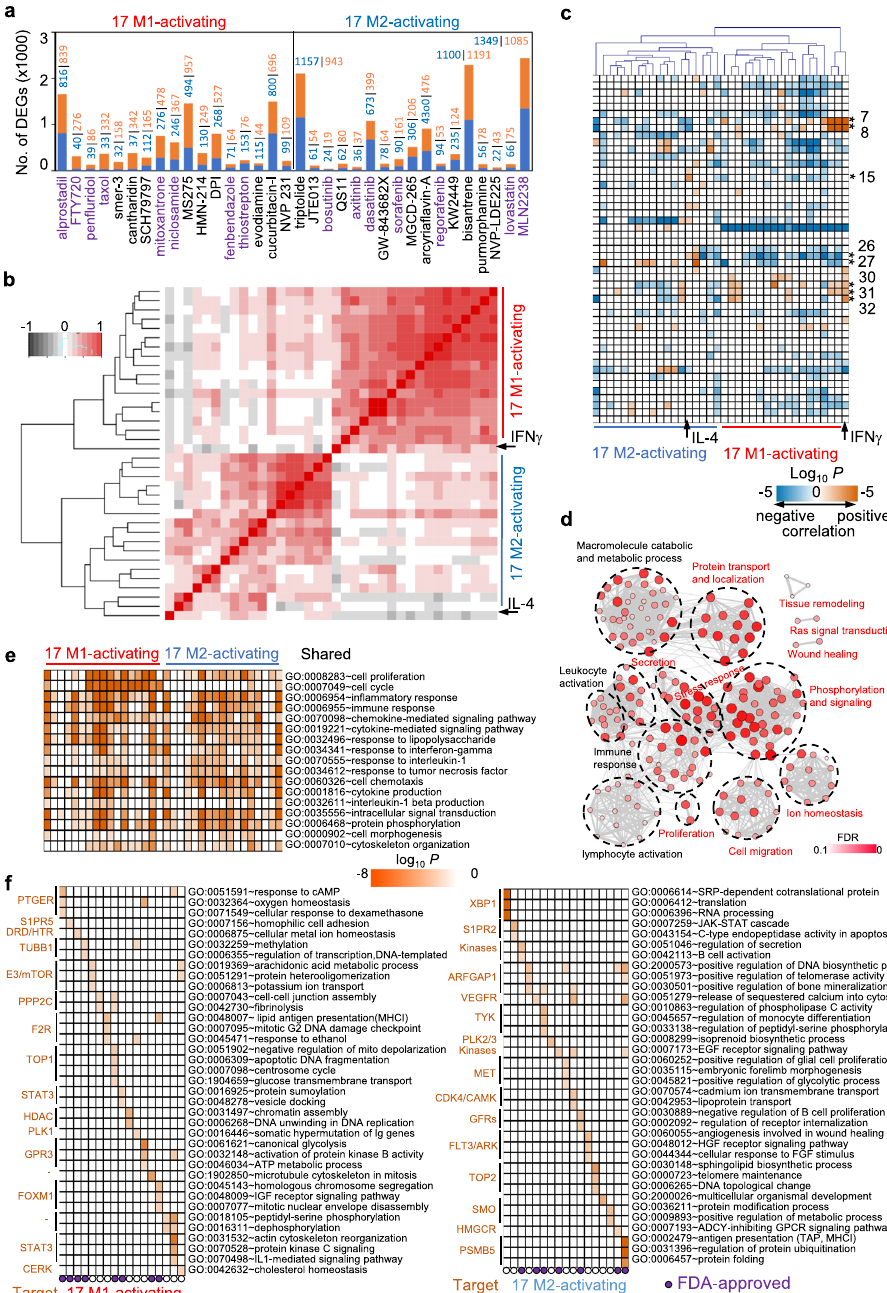
Fig. 4 Reprogramming of differentiated macrophages by selected compounds. a Number of DEGs induced by each compound. Orange: upregulated genes. Blue: downregulated genes. Compounds labeled in purple are FDA-approved drugs. hMDMs were differentiated into either M2 by IL-4 plus IL-13 or M1 by IFN γ plus TNF α and duplicate samples were then treated with either M1-activating or M2-activating compounds, respectively, at the effective concentrations. Controls include two differentiated M1 and M2 macrophages, M2 macrophages treated with IFN γ and M1 macrophages treated with IL-4. Gene expression in each sample was measured by RNA-seq separately. b Hierarchical clustering heatmap of Pearson correlation coef fi cients for 7620 DEGs induced by compounds as well as IFN γ and IL-4. c GSEA analysis of transcriptional responses to each compound as compared to IFN γ and IL-4. The numerical numbers on the right indicate module numbers identi fi ed by Xu et al. 6 . d Network of GO enriched terms using BiNGO on top 10% central hubs genes ( n = 1255) of macrophage activation network. Node color and size represent the FDR values of enriched GO terms. New pathways identi fi ed in this study are labeled in red. e , f Functional enrichment analysis of DEGs induced by each compound. Shared ( e ) and unique pathways ( f ) are shown. Compound targets and FDA-approval information are indicated. The order of M1-activating and M2-activarting compounds in e and f are the same as in a